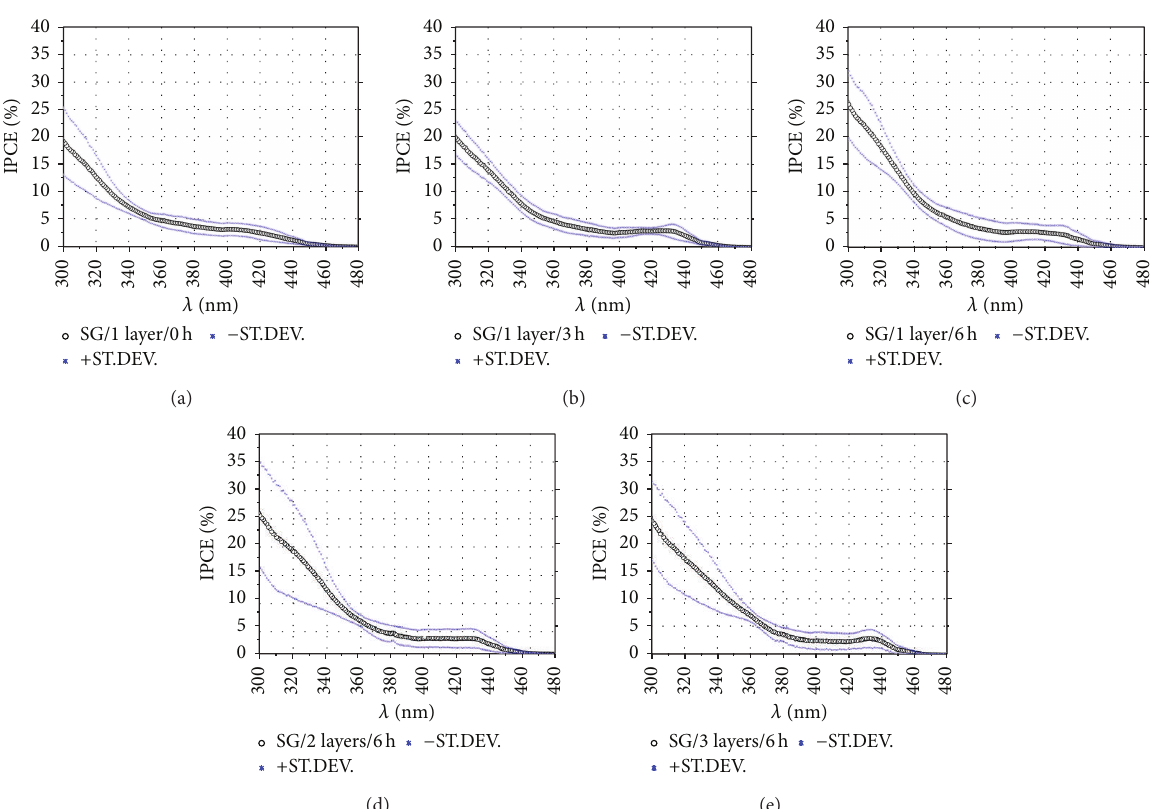
Figure 5: IPCE of the different types of sol-gel photoelectrodes investigated within this study: (a) SG/1 layer/0 h, (b) SG/1 layer/3 h, (c) SG/1 layer/6 h, (d) SG/2 layers/6h, and(e) SG/3 layers/6 h.